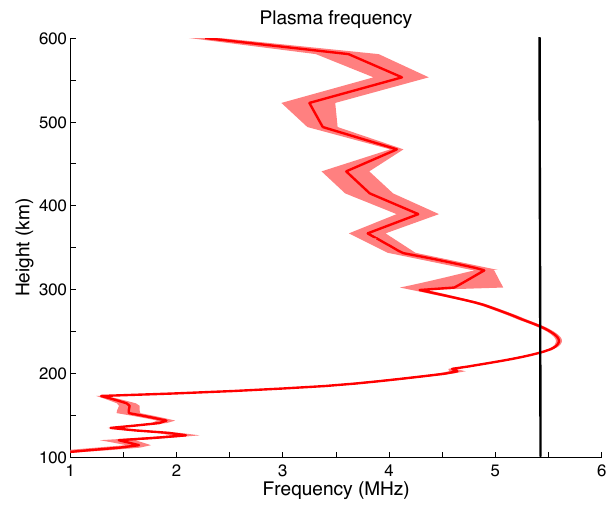
Figure 4. Height profile of f p with f 0 = 5 . 423MHz shown as a solid line (12:04:50UT and integrated for 10s on 26 Novem- ber 2015). The data were obtained from the plasma line up to ∼ 300km altitude and from the ion line at higher altitudes. The width of the profile shows the approximate standard deviation. The time for the profile, a few minutes before the conjunction between the Heating beam and CASSIOPE, was the last time with a usable plasma line height profile that enables determination of f p with high